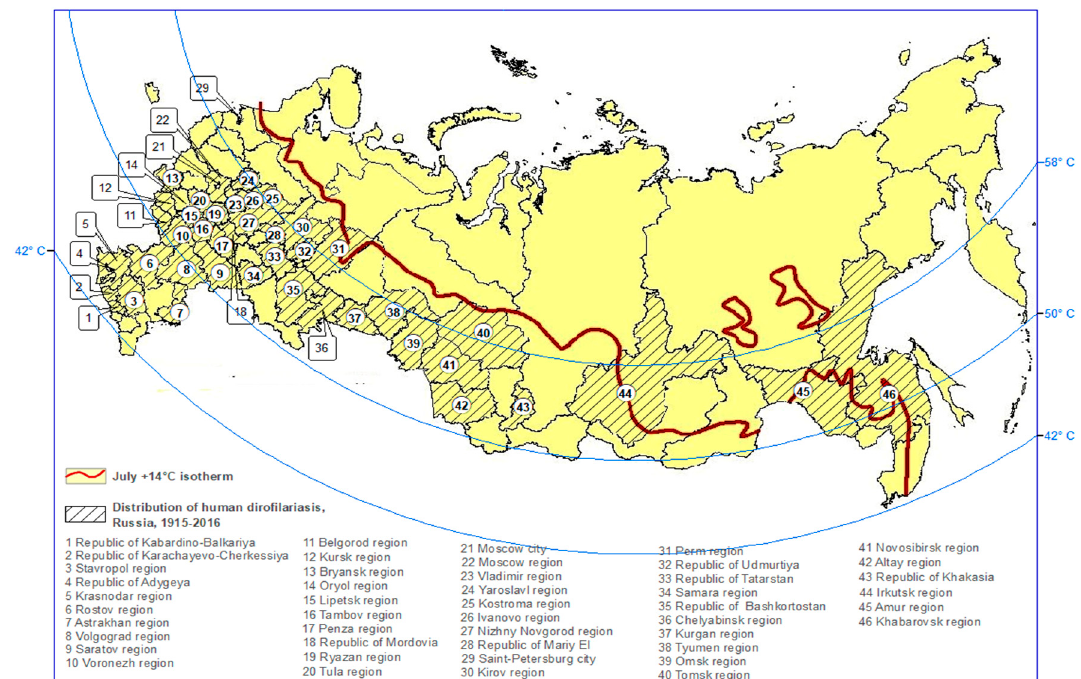
Figure 4. Predicted northern border of the dirofilariasis endemic area in the Russia.